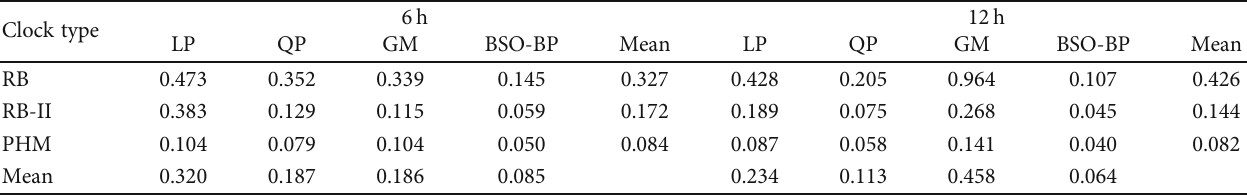
Table 6: The average STD for 1 hour for three di ff erent types of clocks based on 6-hour and 12-hour SCB data. Clock